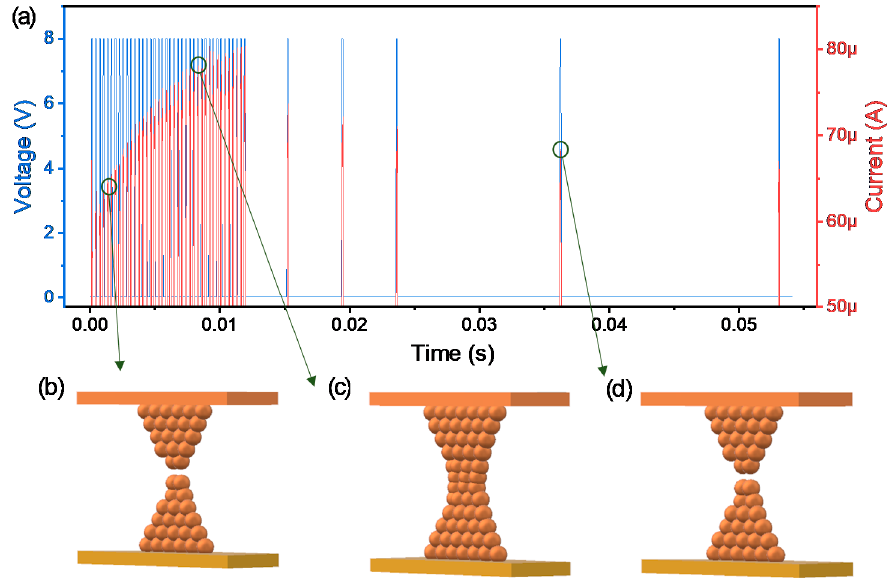
Figure 5. Transient characteristics of Cu / AlN / TiN device for ( a ) STP; Schematics of Cu filament ( b ) Weak filament before evolution; ( c ) growing; ( d ) Spontaneous decomposition.